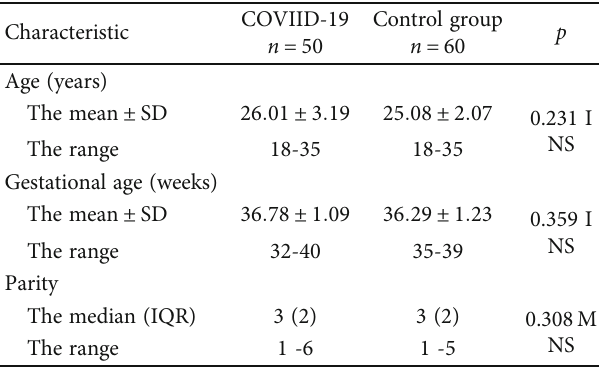
Table 1: Comparison of general characteristics of women with COVID-19 and control